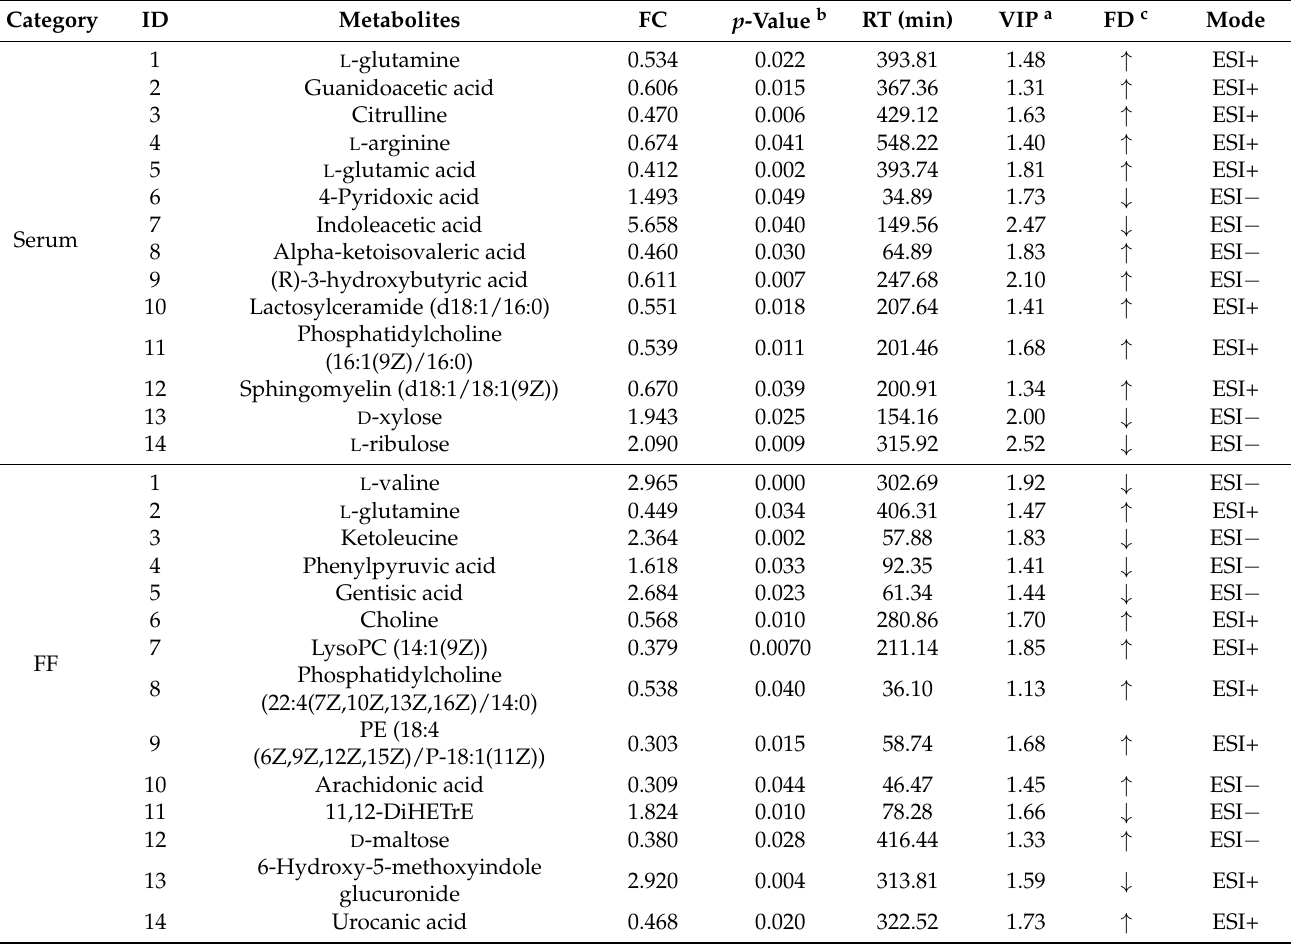
Table 4. Differential metabolites in the serum and FF of the IO and E